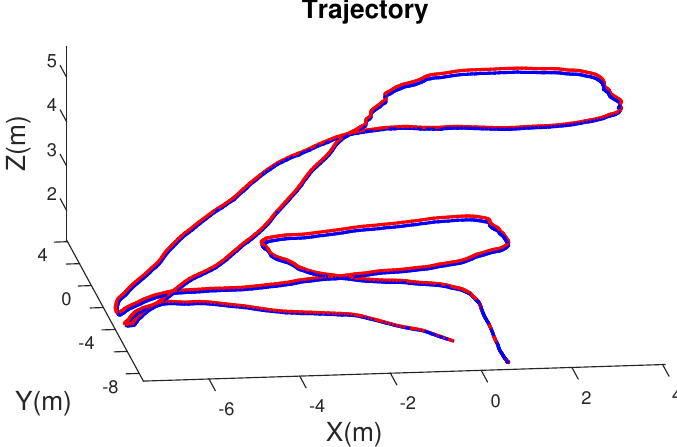
Figure 12. Visual odometry from SLAM algorithm. The red line is the ground-truth trajectory while the blue line is the scaled trajectory of the SLAM algorithm.